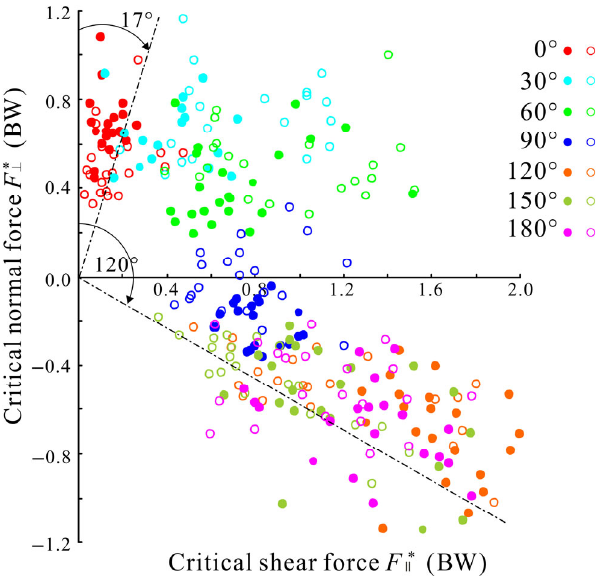
Fig. 7 The critical normal force ( F ⊥ *) vs. the critical shear force ( F || * ) corresponding to the critical angle when the gecko moves on different inclines. The solid points represent the variables for the front foot, whereas, the hollow points represent the variables for the hind foot.